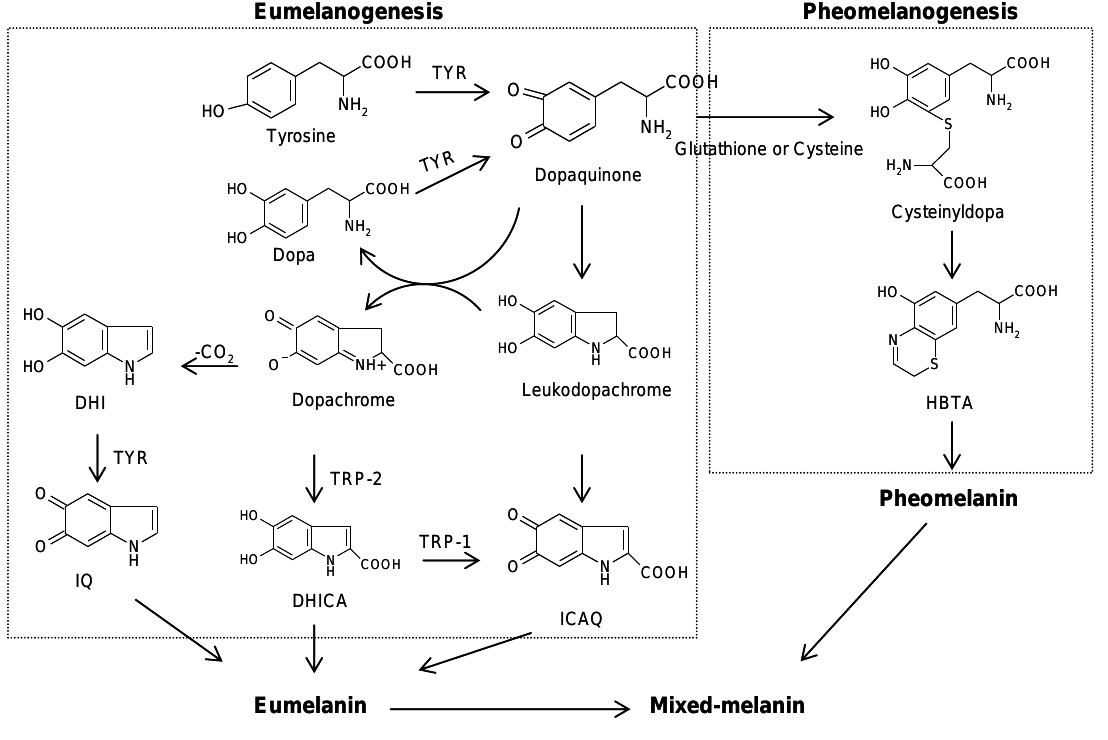
Figure 1. Biosynthetic pathway of melanin [1-4]. TYR, tyrosinase; TRP; tyrosinase related protein; dopa, 3,4-dihydroxyphenylalanine; DHICA, 5,6-dihydroxyindole-2-carboxylic acid; DHI, 5,6-dihydroxyindole; ICAQ, indole-2-carboxylic acid-5,6-quinone; IQ, indole- 5,6-quinone; HBTA,